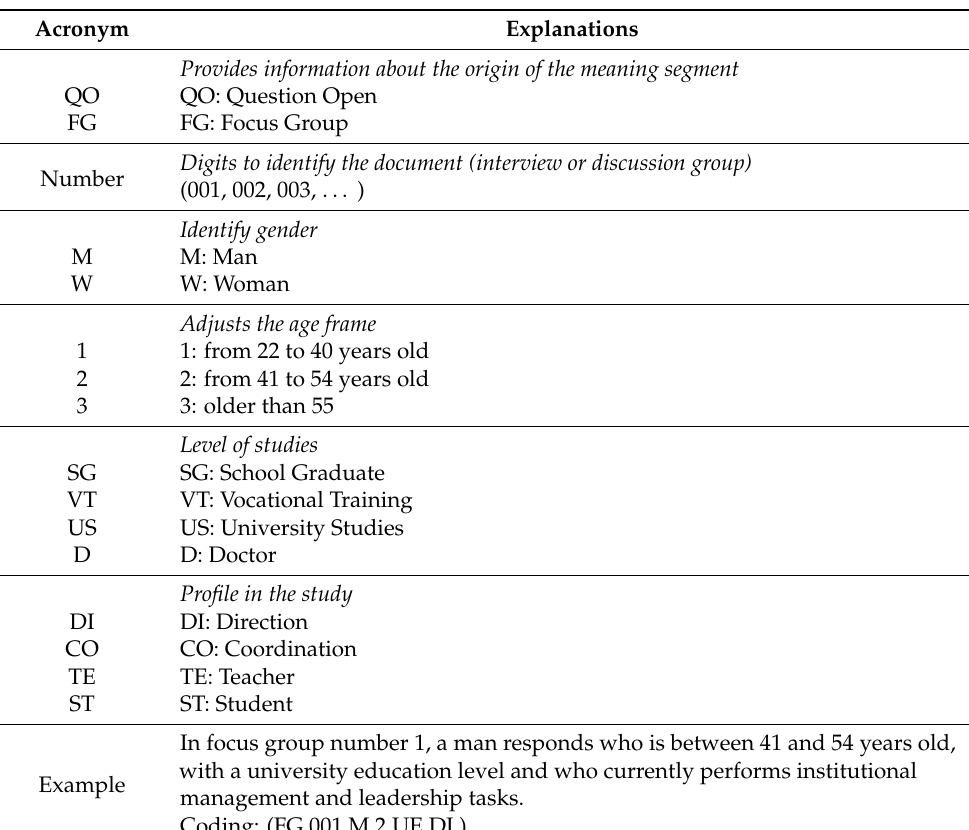
Table 2. Acronyms and explanation for the coding of the participants in terms of the qualitative information collection techniques used for this